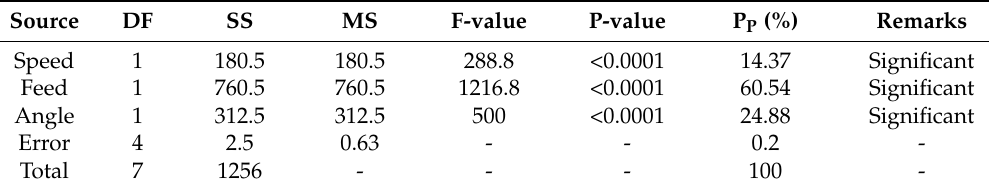
Table 7. ANOVA results for the nodal temperature.